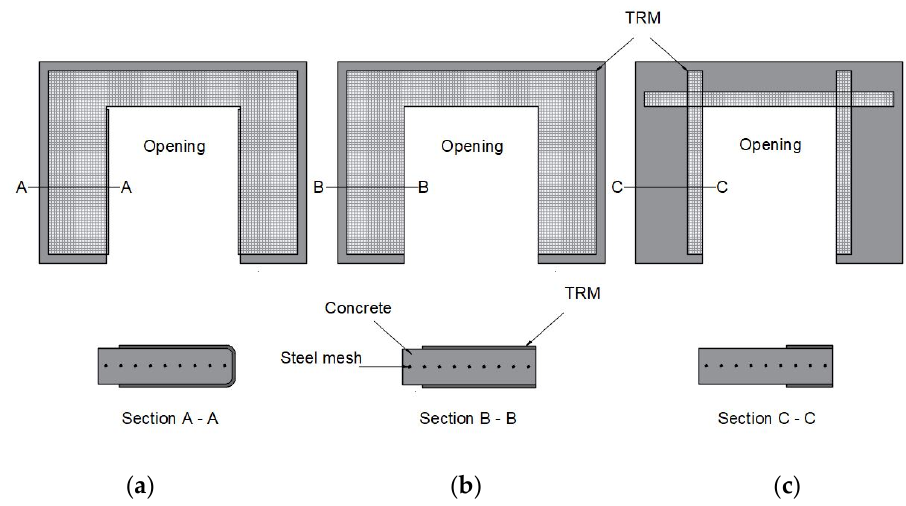
Figure 12. TRM strengthening configurations: ( a ) U-shaped jackets; ( b ) sheets; ( c ) strips. Table 6. Results of wall models with various strengthening configurations.